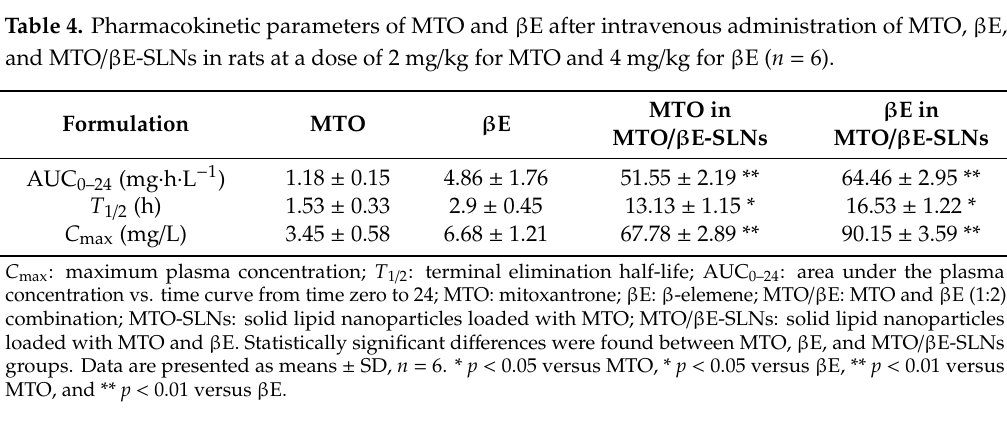
Figure 6. In vivo antitumor efficacies of various MTO formulations in K562/DOX tumor-bearing nude mice. ( A ) The tumor volume changes during the treatment with various formulations. Data are presented as means ± SD, n = 5. * p < 0.05; ** p < 0.01;*** p < 0.001. ( B ) The photograph of excised tumors harvested from each group at the end of the experiment. ( C ) Hematoxylin and eosin (H&E) assays of tumors from K562/DOX tumor xenografts-bearing BALB/c nude mice after being subjected to different treatments for 18 days. Scale bar = 200 μ m. ( D ) TdT-mediated dUTP nick-end labeling (TUNEL) assays of tumors from K562/DOX tumor xenografts-bearing BALB/c nude mice after being given different treatments for 18 days. Scale bar = 200 μ m. 5. Conclusions The overall goal of this work was to combine and successfully load MTO (anticancer drug) and β E (P-gp inhibitor agent) into SLNs with a precise weight ratio of 1:2 ( w / w ), which displayed the highest synergistic effect. Optimized nanoparticles (MTO/ β E-SLNs) possessed suitable particle size, negative zeta potential, high drug loading, and good colloid stability. Importantly, the cytotoxicity, cellular uptake, and significant reversal of drug resistance in K562/DOX cells of MTO/ β E-SLNs were significantly improved compared to other MTO formulations. The pharmacokinetics study in SD